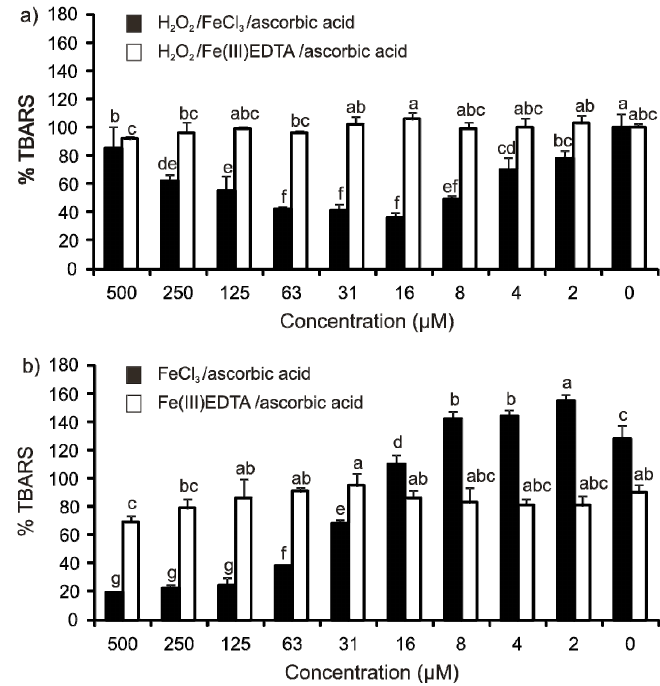
Figure 2. Thiobarbituric acid reactive species (TBARS) formation in ( a ) H O /Fe(III)/ascorbic acid (1 h incubation) and ( b ) Fe(III)/ascorbic acid (16 h 2 2 incubation) variants of the deoxyribose degradation assay (100% = TBARS of the control reaction mixture of the classical variant; H H O /Fe(III)EDTA/ascorbic acid). EDTA, ethylenediaminetetraacetic acid. Error bars 2 2 indicate the standard deviation of three replicates; letters (a, b, c, d, e, f and g) indicate different levels of significance (95%